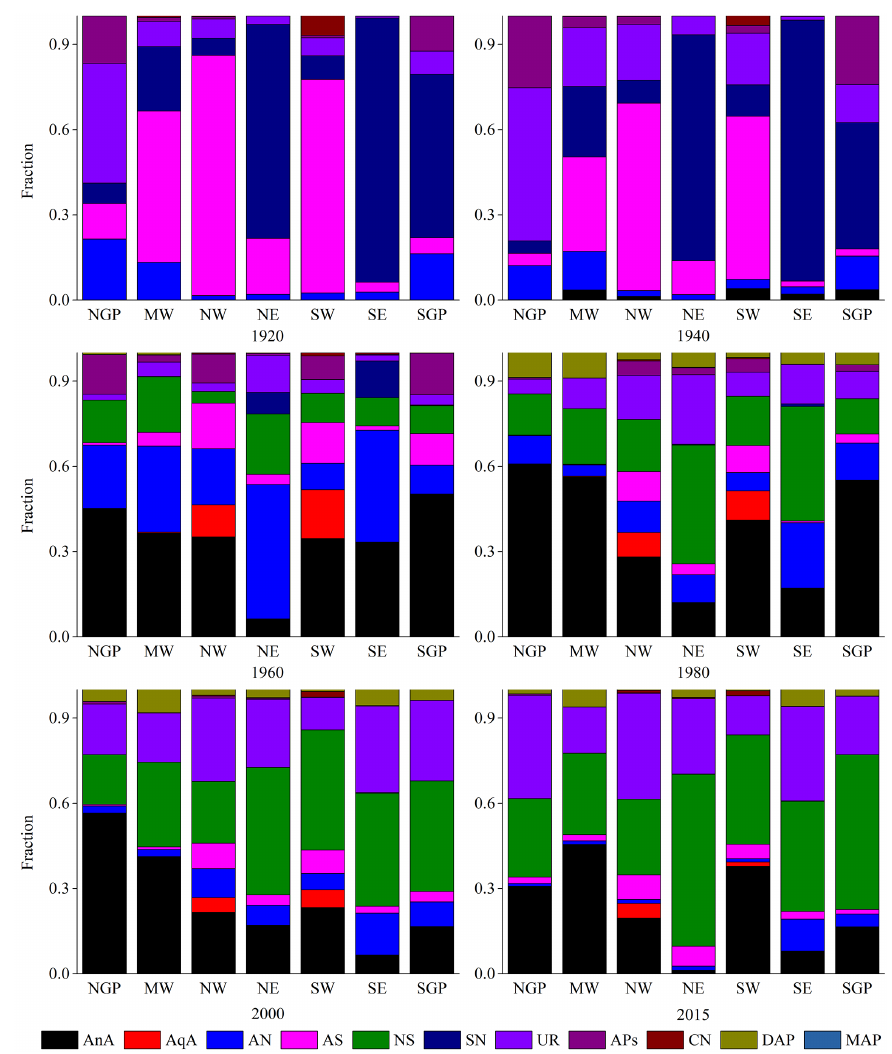
Figure 5. Regional fraction of the 11 N fertilizer types from 1920 to 2015. The fraction was the percentage of the N content of each N fertilizer to the total N consumption. The 11 N fertilizers include anhydrous ammonia (AnA), aqua ammonia (AqA), ammonium nitrate (AN), ammonium sulfate (AS), nitrogen solution (NS), sodium nitrate (SN), urea, calcium nitrate (CN), diammonium phosphate (DAP), monoammonium phosphate (MAP), and ammonium phosphates